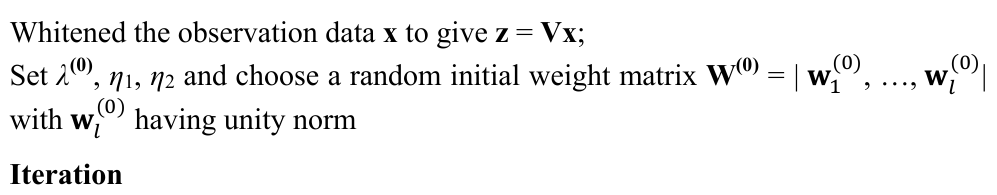
Algorithm 2. The symmetric extracting algorithm with spatial